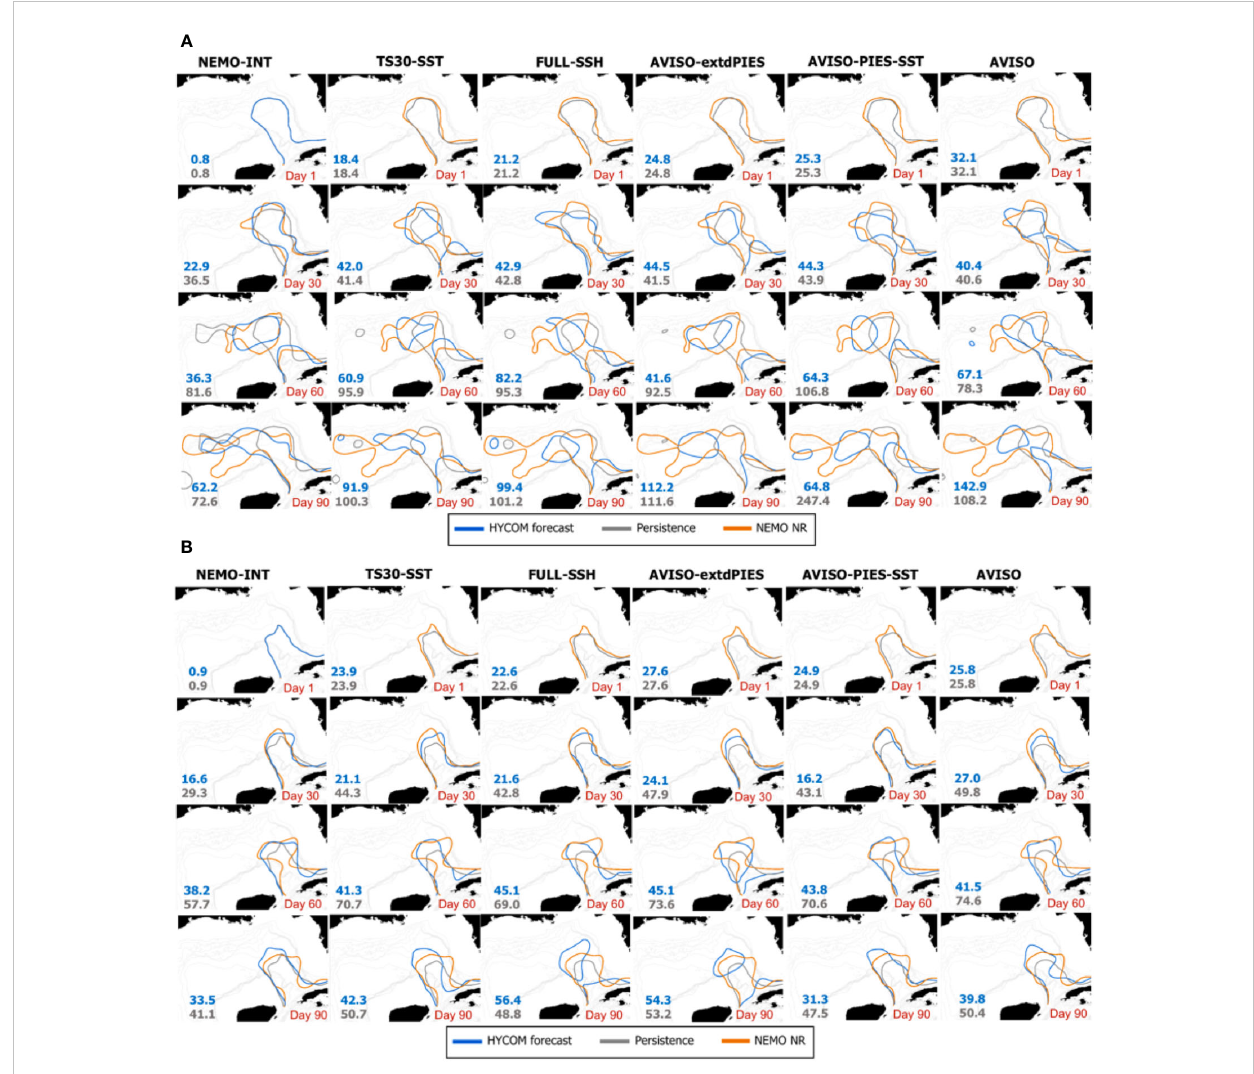
FIGURE 14 Example of the LC/LCE contours (fronts) from one of the OSSE forecasts in each forecast group (in columns) and corresponding contours from the NEMO NR during 2010 (A) and 2011 (B) . The blue contours correspond to the OSSE forecasts and the orange contours are from the NR. The grey contours show persistence prediction. In the fi rst row in (A, B) , the initial state (day 1) is shown. The LC contours from the OSSE forecasts and persistence coincide demonstrating a perfect match of the initial contours from the “ NEMO-INT ” and the NR. The numbers are MHD scores for the shown contours from the forecast - NEMO NR (blue) and persistence - NEMO NR